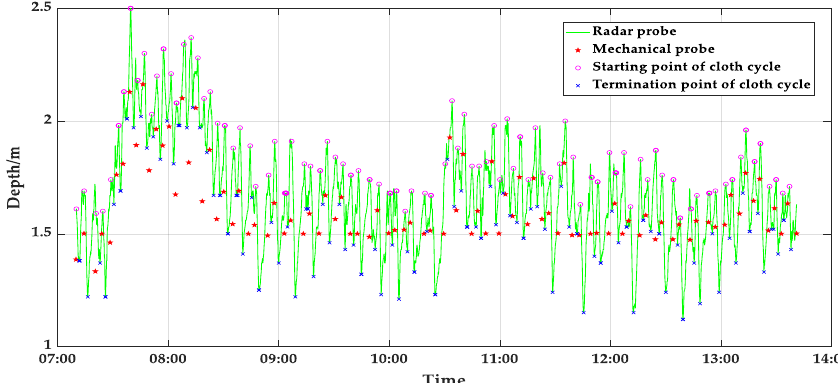
Figure 17. Depth of burden surface as determined using traditional